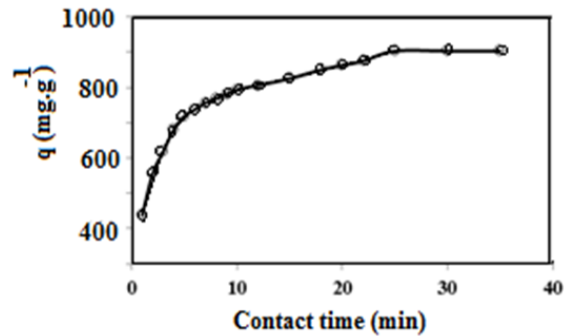
Figure 10. Relation between adsorption capacity of QVP / AAm-Fe 3 O 4 for CR and contact times to its aqueous solution at room